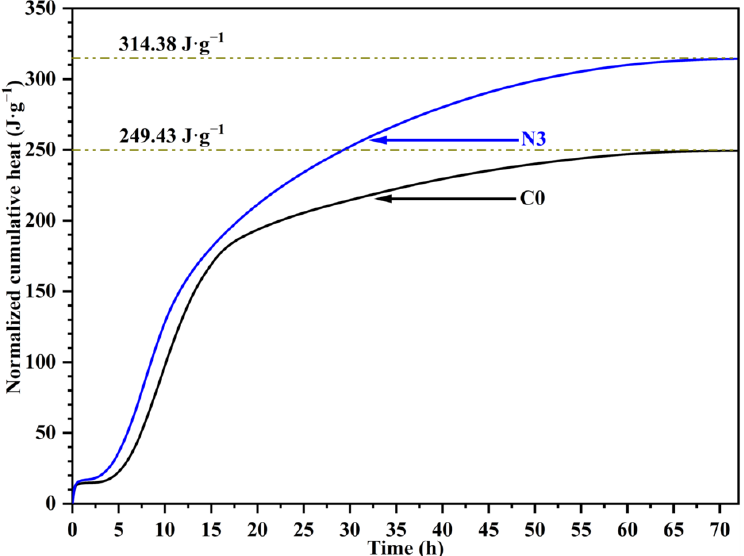
Figure 14. The accumulated heat of different samples.